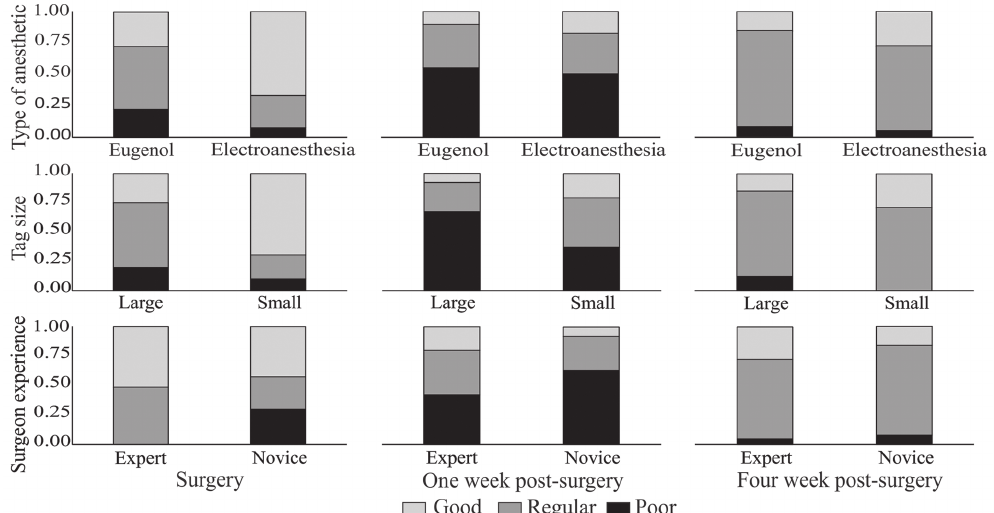
Fig. 5. Surgical/postsurgical ranking of Prochilodus lineatus over four weeks. Black: poor; gray: average; and light gray: